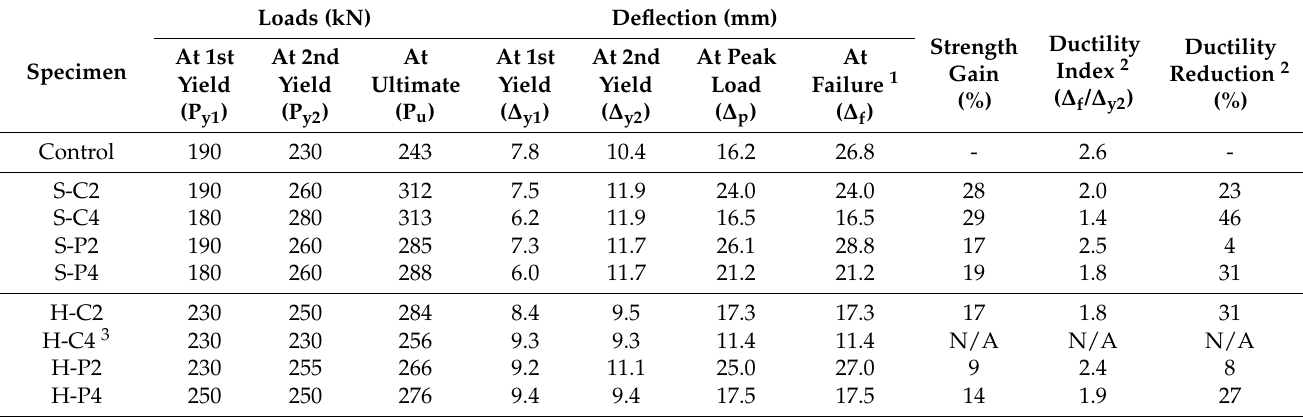
Table 3. Summary of test